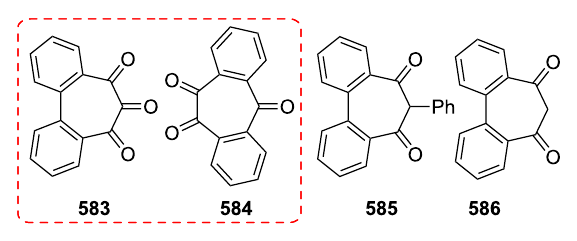
the activated methylene group of diketone 586 with selenium dioxide [256,257]. Oxidative degradation of diketone 585 with nitric acid also provided 583 (Figure 36) [258,259]. The synthe- sis of dibenzotropoquinone 584 was realized via SeO 2 -medi- ated oxidation of 5 H -dibenzo[ a,d ][7]annulen-5-one ( 399, Figure 19)